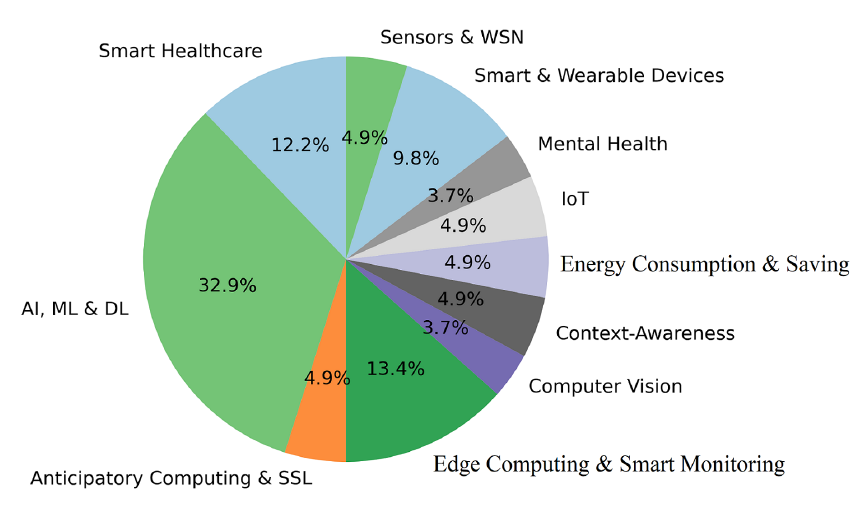
Figure 8. Relative popularity of the identified subjects assessed on the based of the keywords’ frequency. The most popular subject is AI, ML and DL followed by Edge Computing and Smart Monitoring, Smart Healthcare and Smart and Wearable